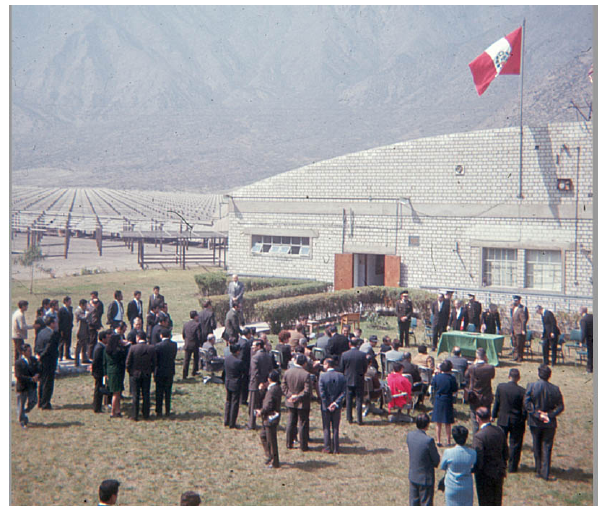
Figure 22. Ceremony transferring Jicamarca Radio Observatory from the United States government to Peru in 1969 (picture taken by Ben